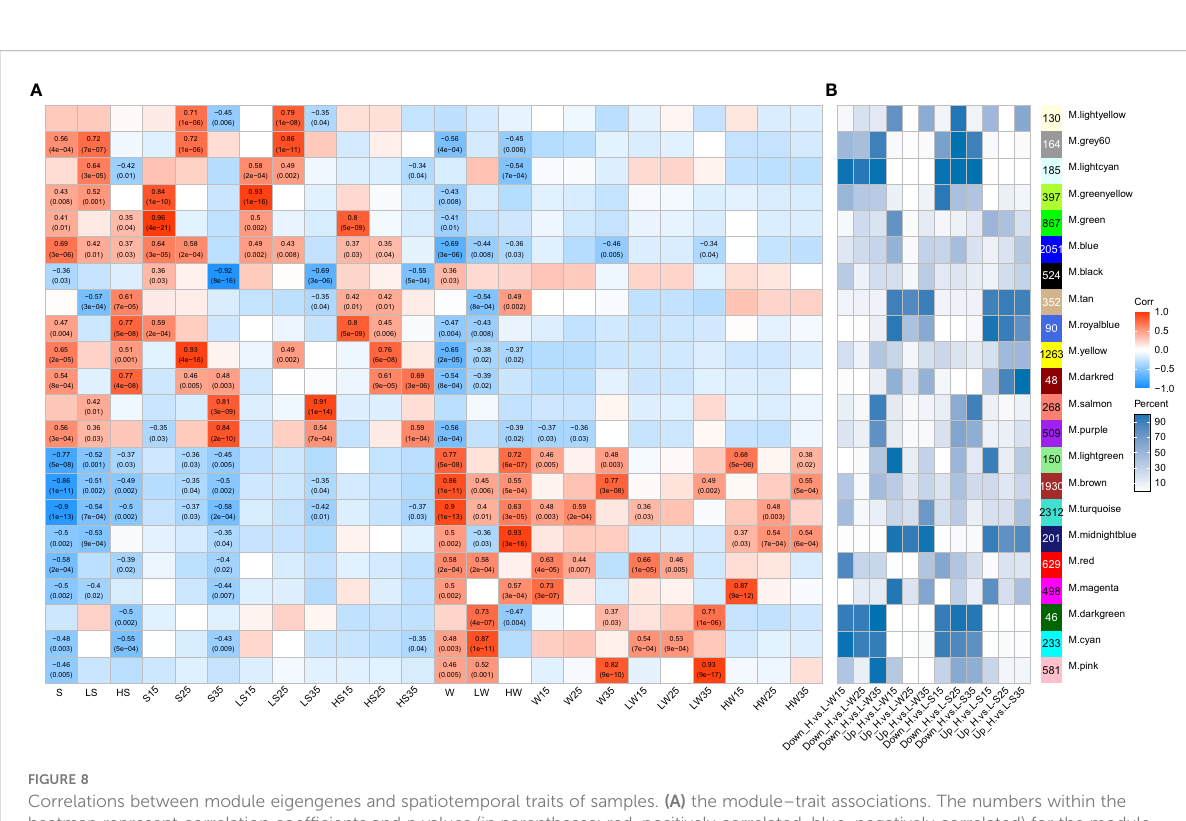
M.pinkM.cyanM.darkgreenM.magentaM.redM.midnightblueM.turquoiseM.brownM.lightgreenM.purpleM.salmonM.darkredM.yellowM.royalblueM.tanM.blackM.blueM.greenM.greenyellowM.lightcyanM.grey60M.lightyellow